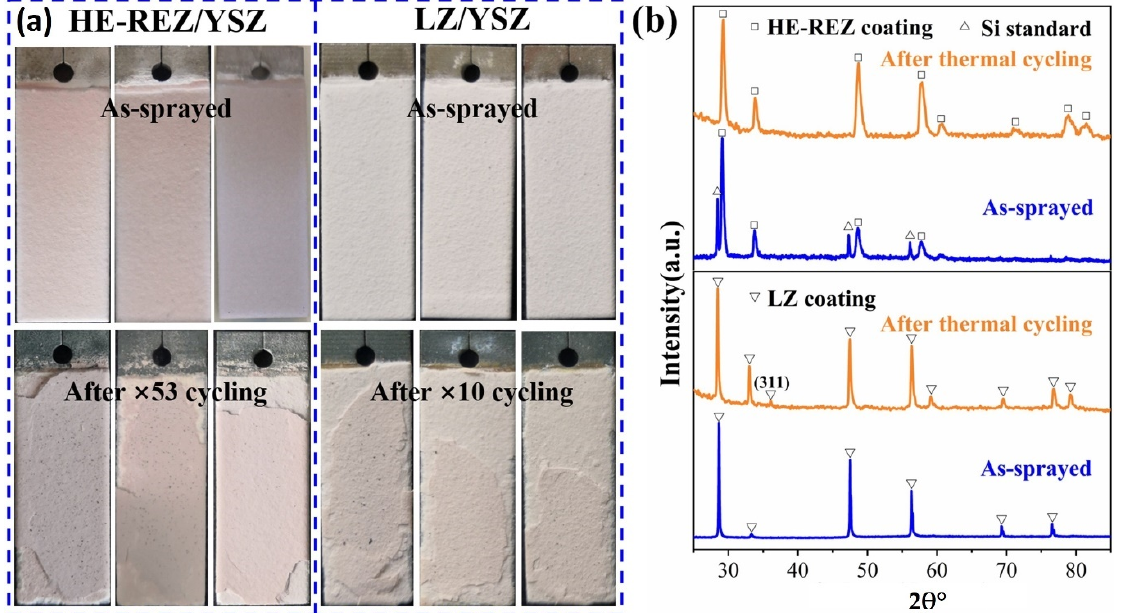
Figure 8. ( a ) Photographs and ( b ) XRD patterns of the as-sprayed coating and after thermal cycling test. Reprinted with permission from [35] Copyright 2020 Elsevier .